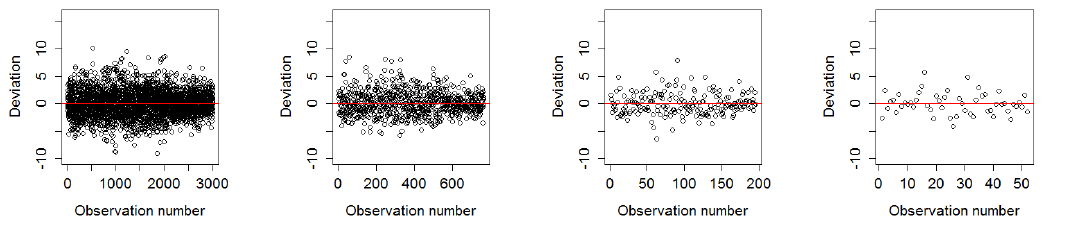
Figure 10. Deviation of residuals around the mean of 1990 in all four resolutions as best model